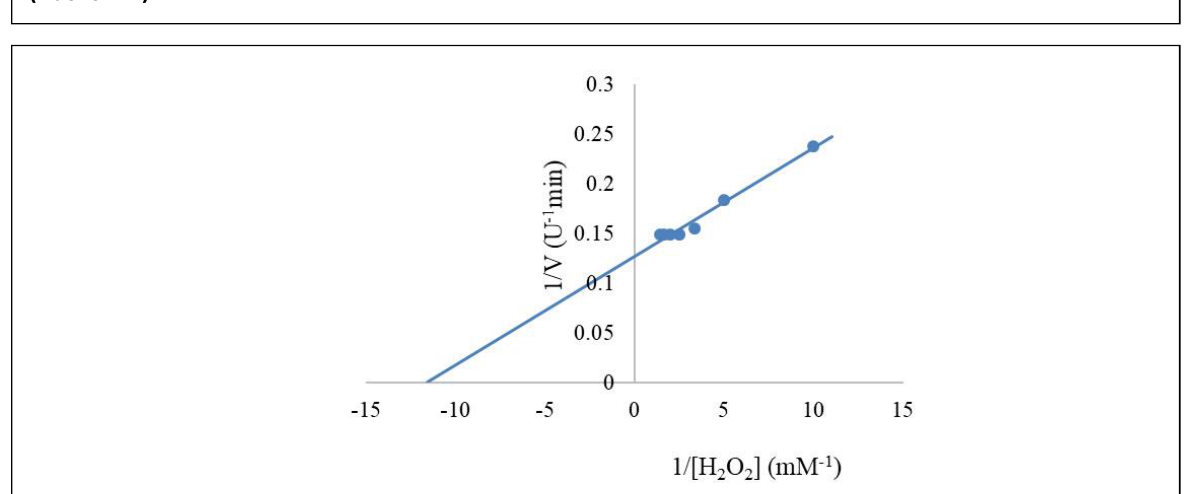
Figure 3: Michaelis-Menten plot of peroxidase activity using graded concentrations of hydrogen peroxide (fraction A)